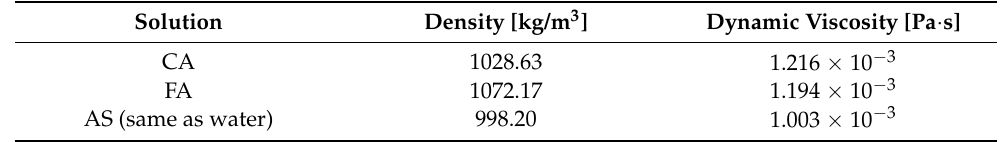
Table 1. Physicochemical parameters of reagents used